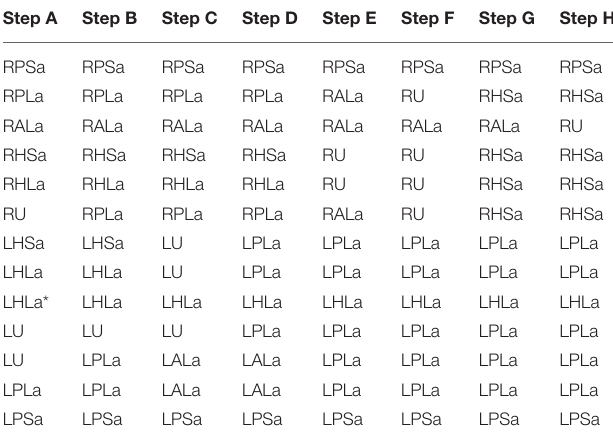
TABLE 2 | Changes of otolith position at different positions during the right barbecue